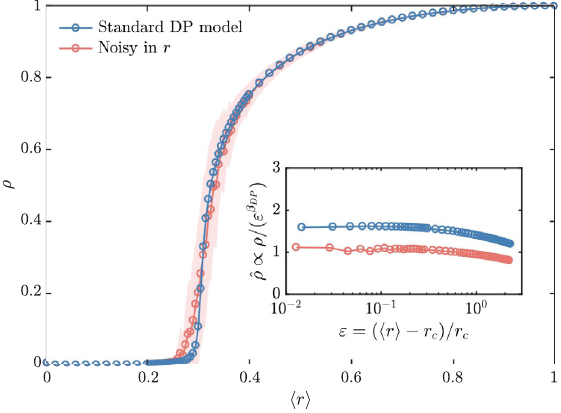
simulation.FIG. 10. Turbulent fraction for the baseline DP model (in blue) according to Ref. [5], compared with a modified model (in red) that allows a noisy parameter r , which changes in time according to a standard normal distribution with a standard deviation of σ ≈ 0 . 02 and a fixed average h r i . This average value plays the role of the “ new ” control parameter. In the inset, the respective compensated representation indicates a first-order phase transi- tion for both cases. Please note that the critical point is adjusted to each